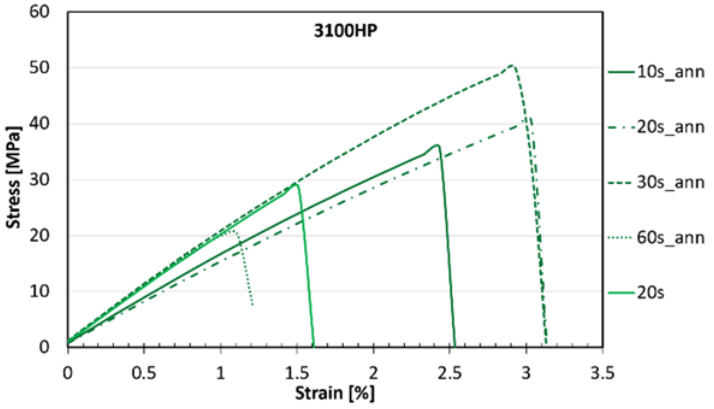
Figure 7. Stress–strain curves of SR–PLA composites.